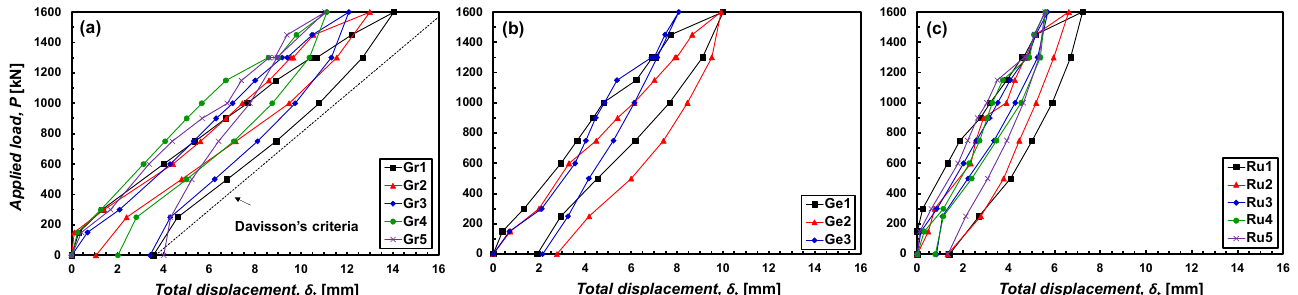
Figure 4. Results of tension load tests. ( a ) Micropiles installed using only gravitational grouting ( Gr ), ( b ) geotextile packer ( Ge ), and ( c ) rubber packer ( Ru ).